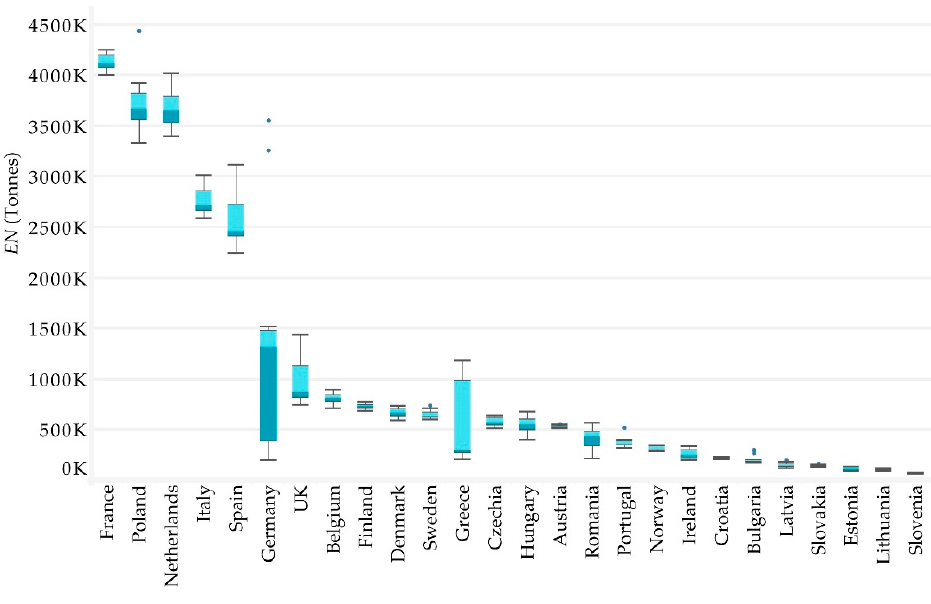
Figure 5. Annual Energy Consumption ( EN ) per country for the period 2005–2019.